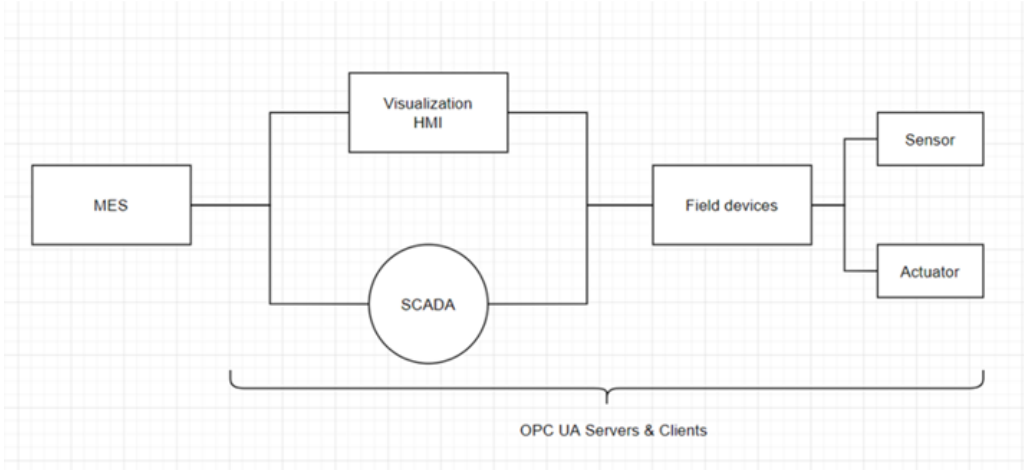
Figure 9. Scenario configuration using Python FreeOpcUa.